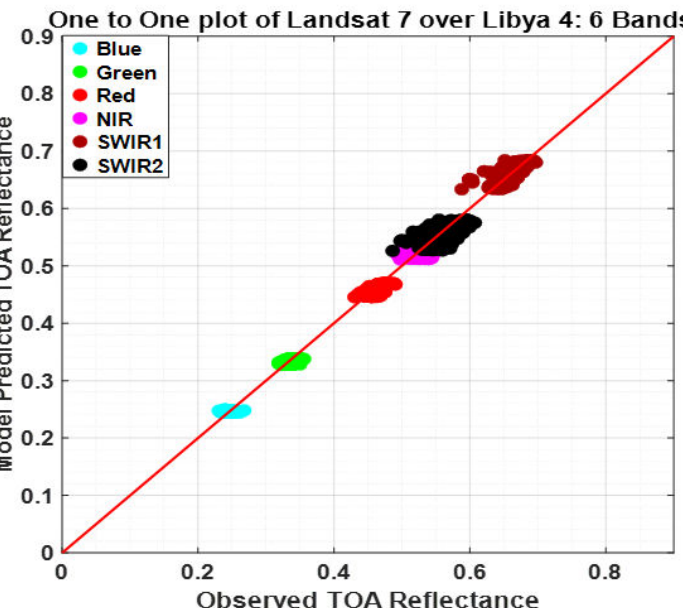
Figure 10. Comparison of the hyperspectral APICS model predicted TOA reflectance and the corresponding observed L7 bands. Red solid is the reference line.